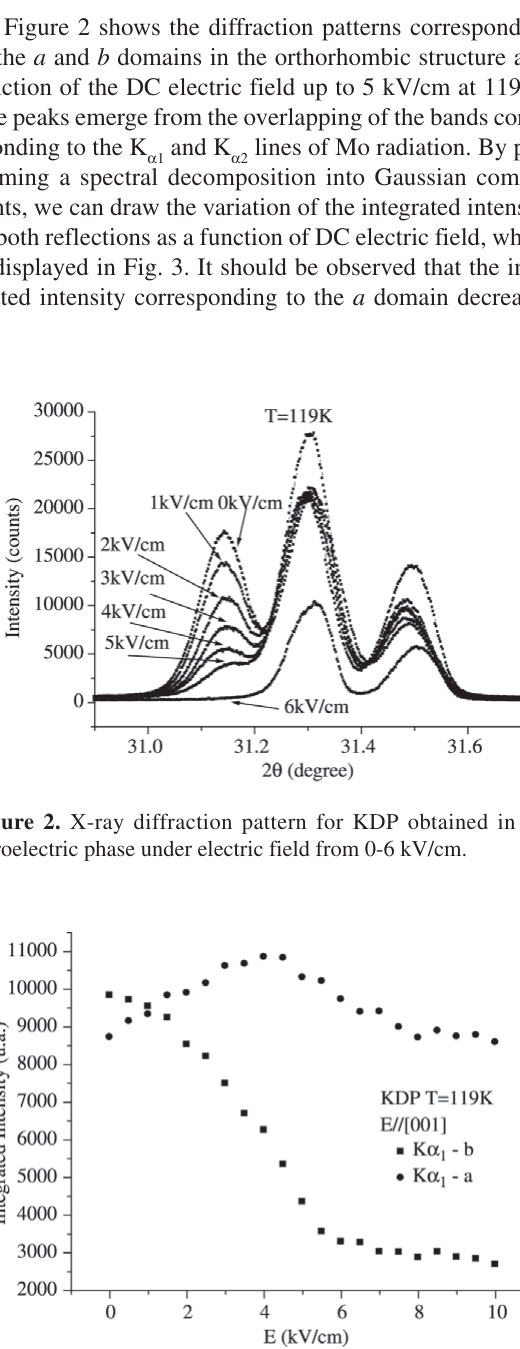
Figure 3. Integrated intensity for the a and b domains versus elec- tric